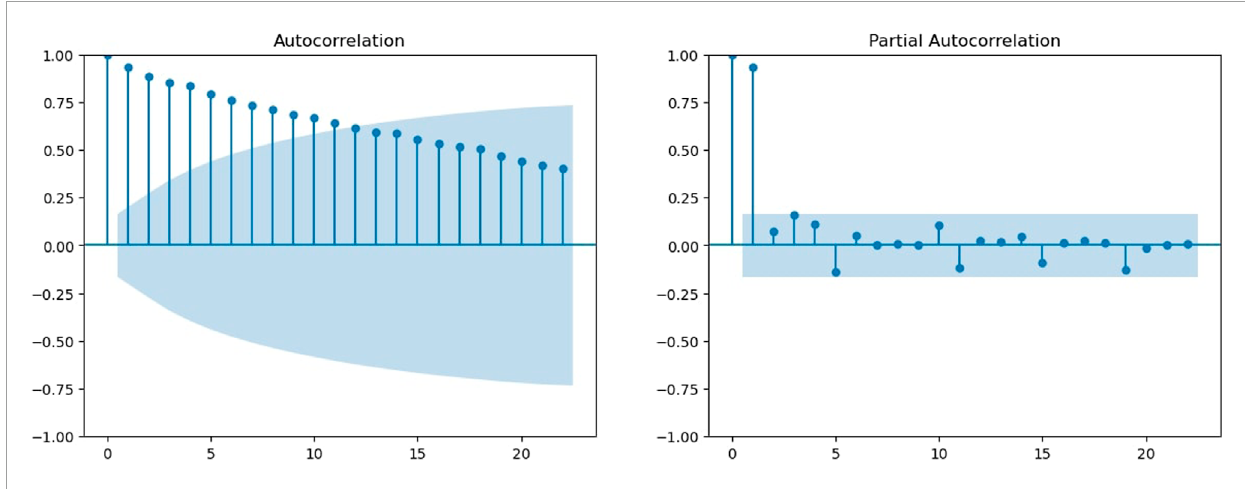
where ϕ , θ ≠ 0 and σ 2 ≥ 0. The parameters p and q are called the p q w autoregressive and the moving average orders,